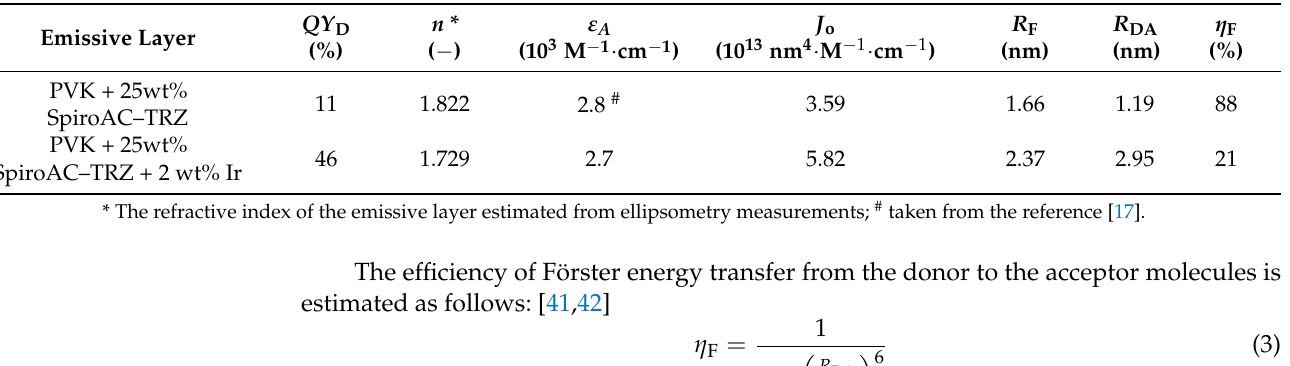
Table 2. Förster energy transfer parameters of active layers with SpiroAC–TRZ as the guest and as the assistant dopant with target phosphorescent